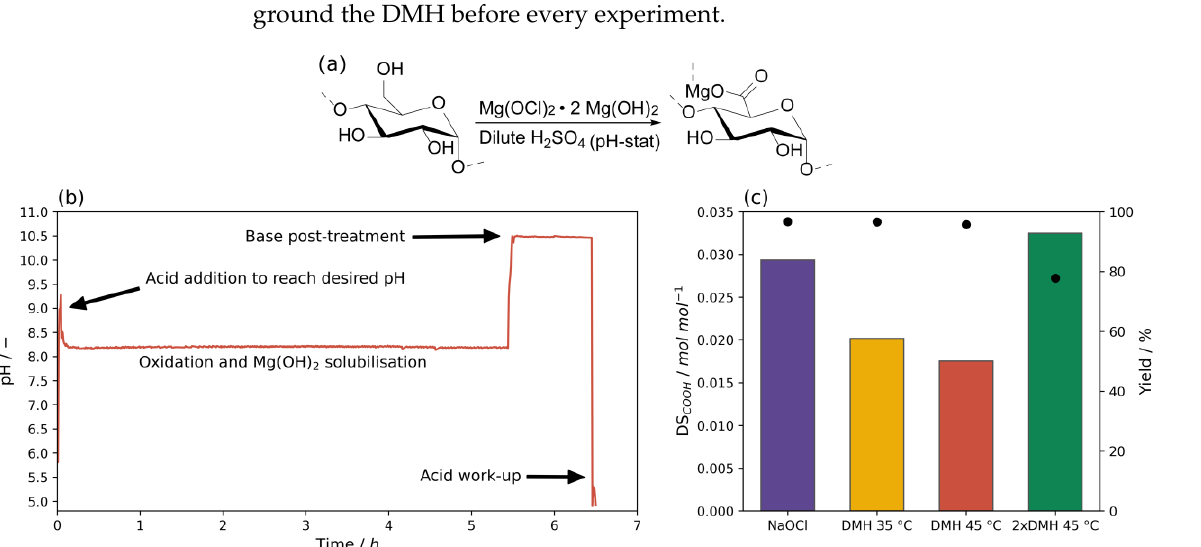
Figure 1. ( a ) Reaction scheme for the oxidation of starch using dibasic magnesium hypochlorite (DMH), acid addition needed to promote the solubility of DMH. The oxidation of the primary alcohol is taken as an example; see scheme S1 for the full mechanism and oxidation on other positions. ( b ) pH in time of a reaction of starch with DMH (pH 8.2, 45 °C, 4.2 mol% DMH), showing the various stages of the reaction. ( c ) Degree of oxidation (DS COOH , bars) and starch recovery yield (dots) of starch after oxidation with NaOCl (pH 8.2, 35 °C, 8.5 mol% -OCl) and DMH under various reaction conditions (pH 8.2, 8.5 mol% -OCl, except 2xDMH, which was with 17 mol% -OCl).